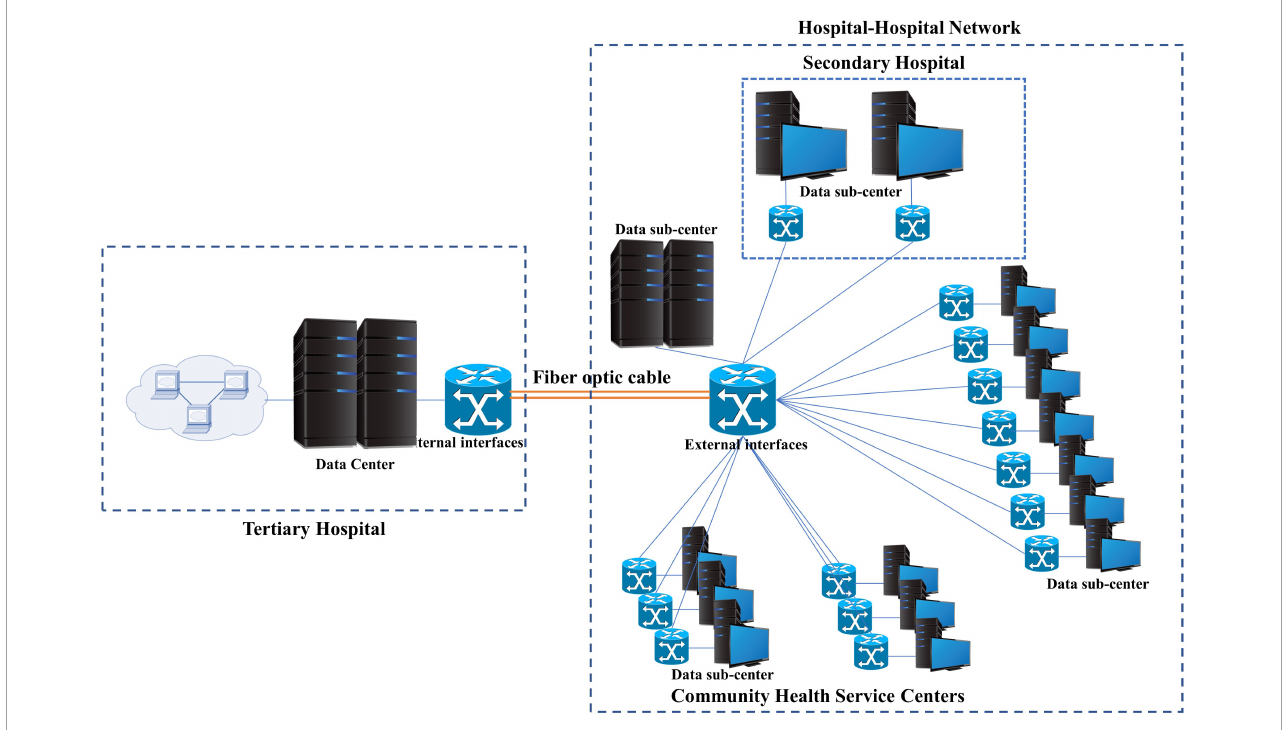
FIGURE1 Topology of the three-level stroke rehabilitation